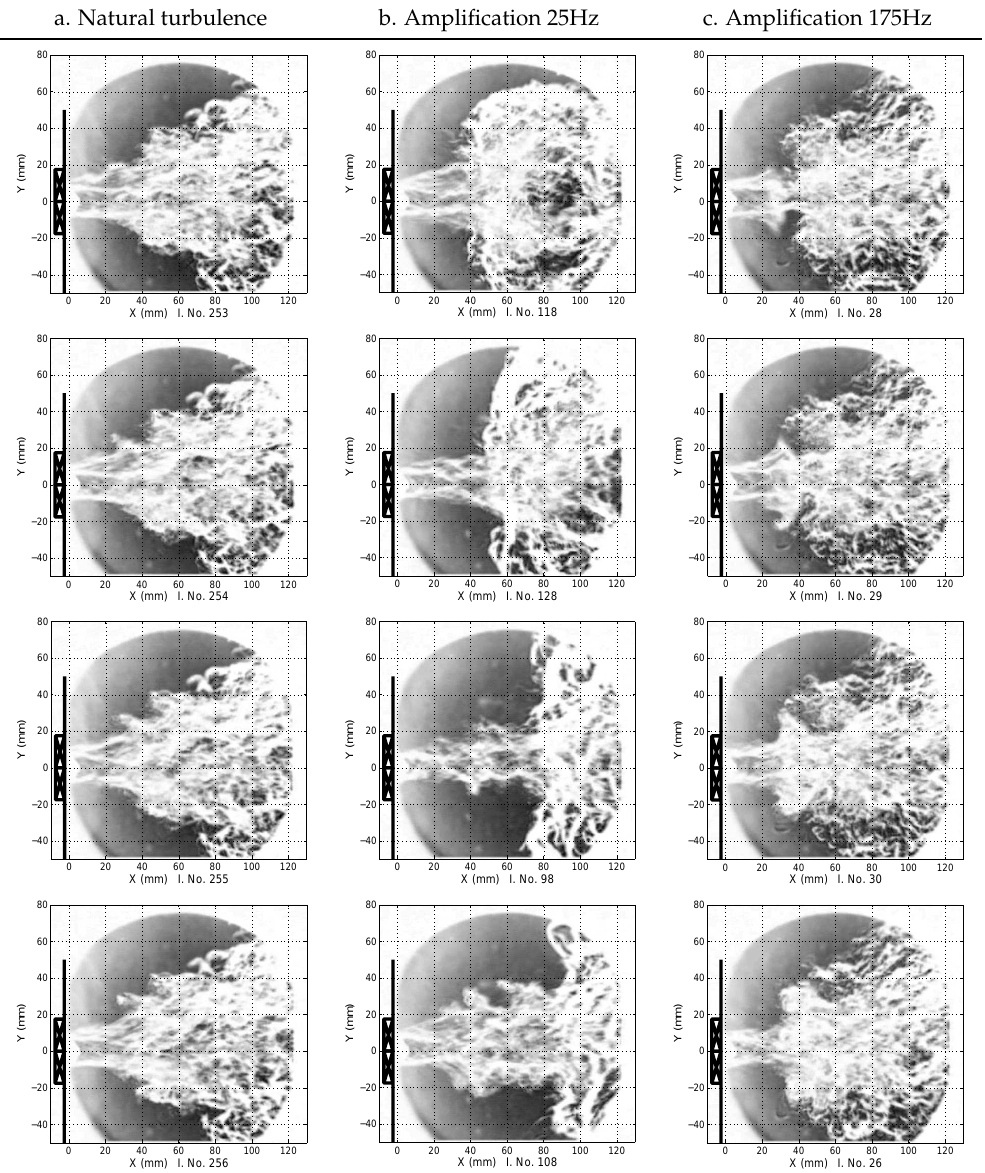
Figure 26. High speed schlieren visualisations (1000 fps, single frame, full sensor resolution) on a premixed air-methane flame in free-jet configuration. Column ( a ): Turbulent flame. ( b ): Amplification 25 Hz. ( c ): Amplification 175 Hz. All consecutive pictures are chosen and arranged so that one complete pulsation cycle is visible for the modes 25 and 175 Hz. Inverted